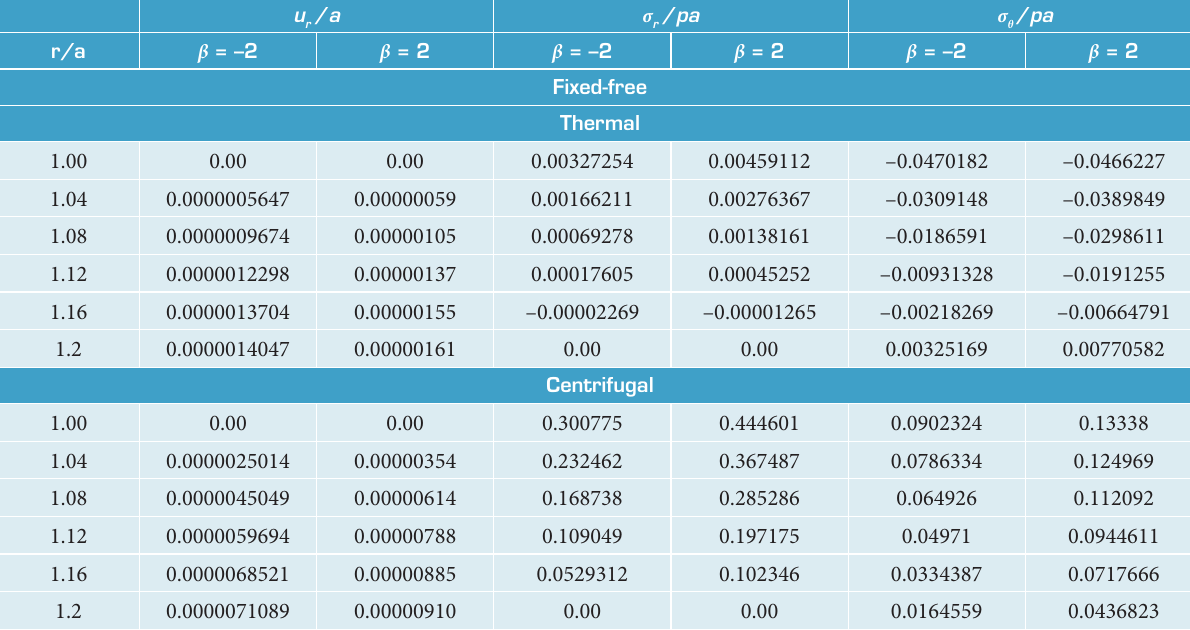
Table 1. Variation of the dimensionless elastic fields with the inhomogeneity index under individual and combined loads for mounted rotating